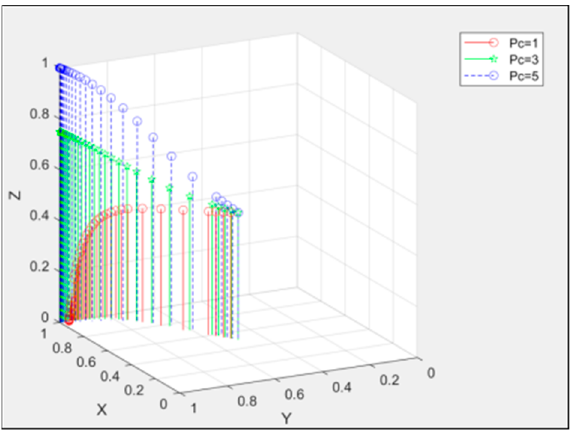
Figure 11. The influence of subsidizing PC on the strategic choice of all parties.